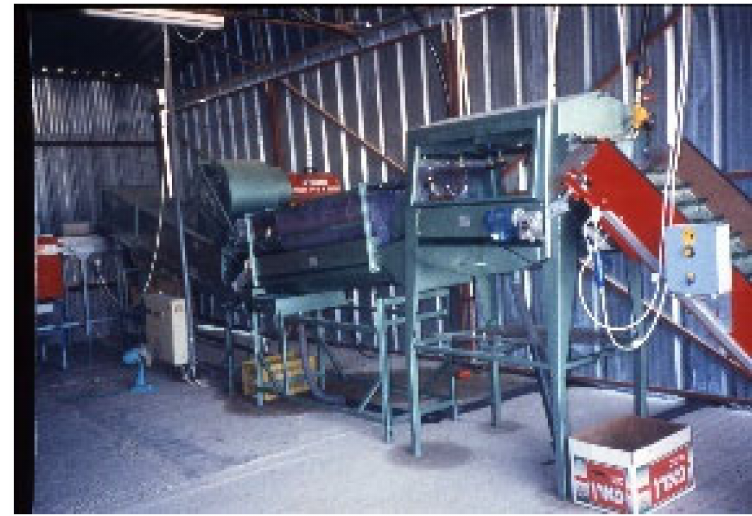
Figure 2. Second version—first commercial-scale machine, 1997 (photo by E. Fallik).